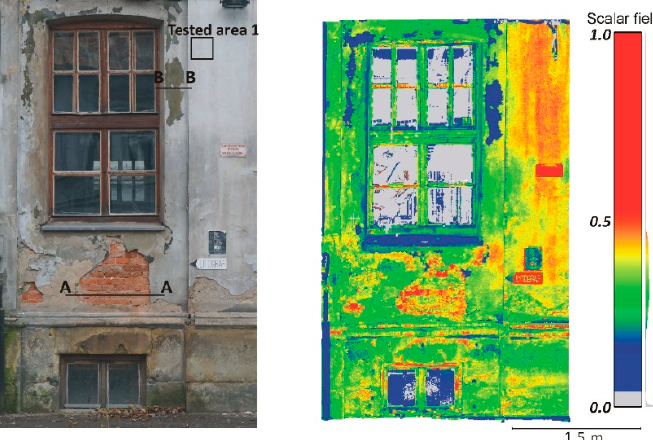
Figure 1. Part of the tobacco factory building—real photo on the left, point cloud on the right.